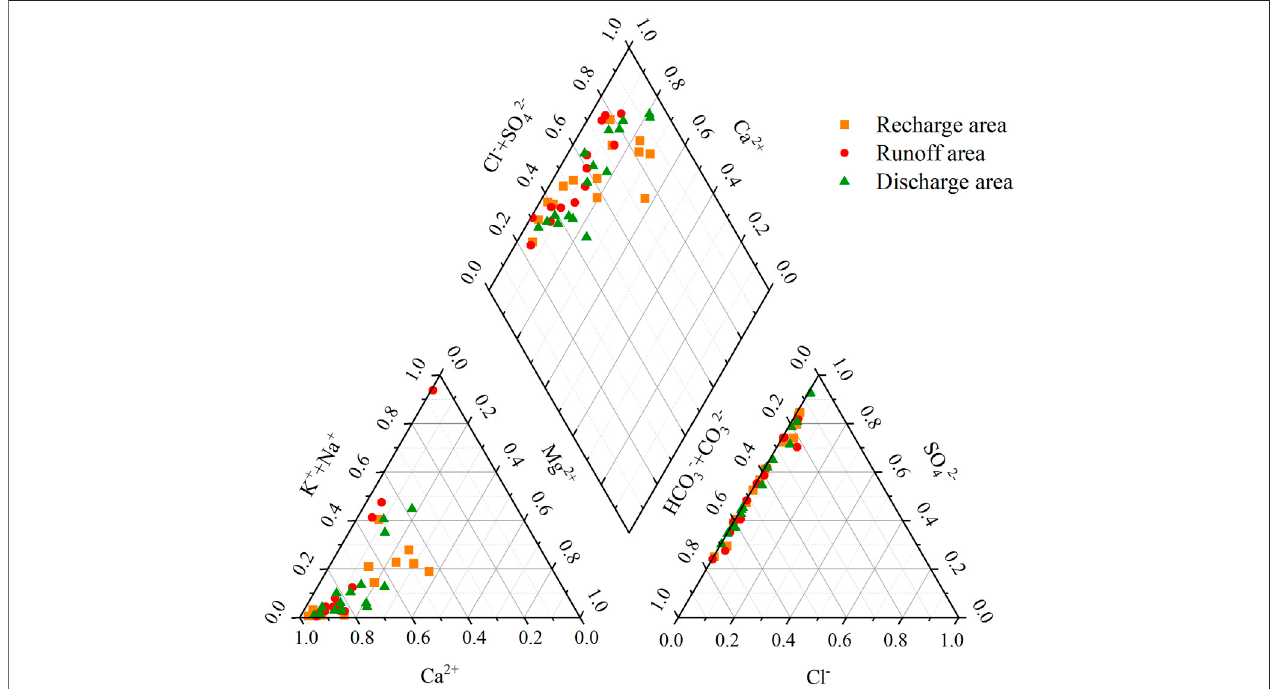
FIGURE 4 | Piper diagram of the ionic composition of the groundwater samples from D 3 x 4 .